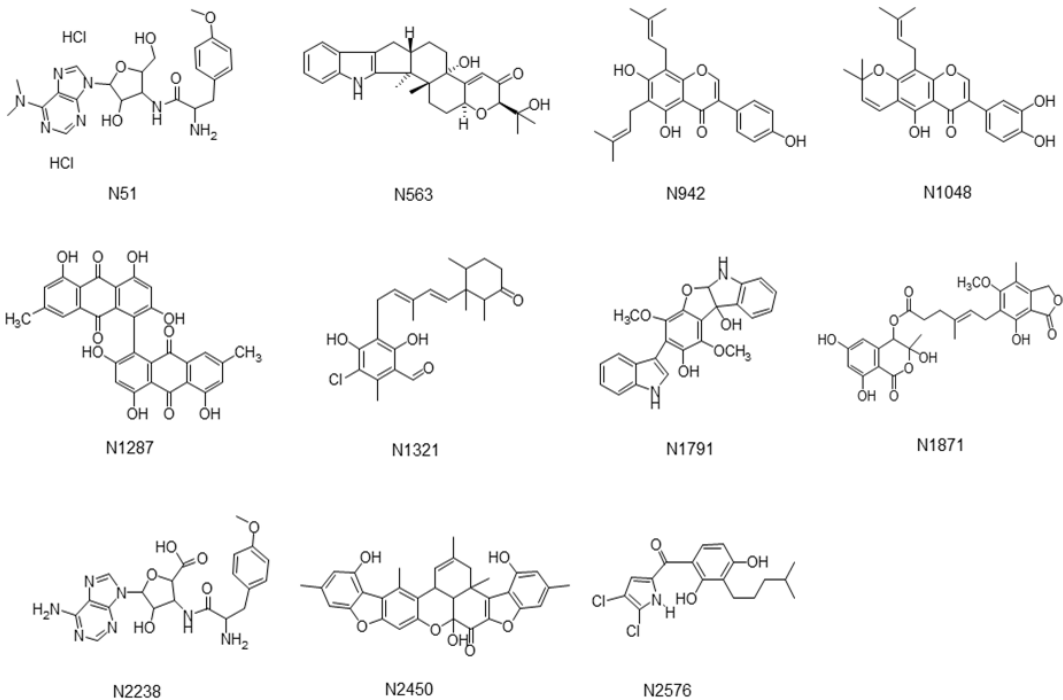
Figure 1. Structures of eleven in silico predicted natural compounds.